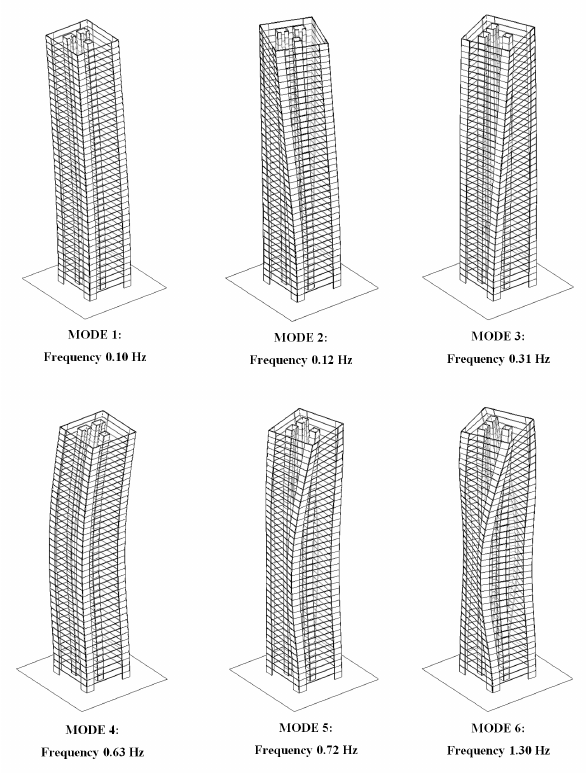
Figure 12: The first six mode shapes and the corresponding natural frequencies.